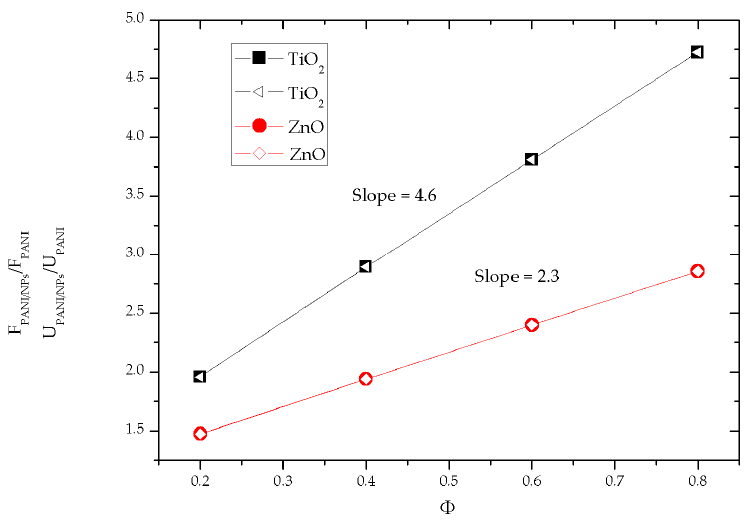
Figure 11. The scaled vdW energy and force of PANI/NPs to those of pure PANI.